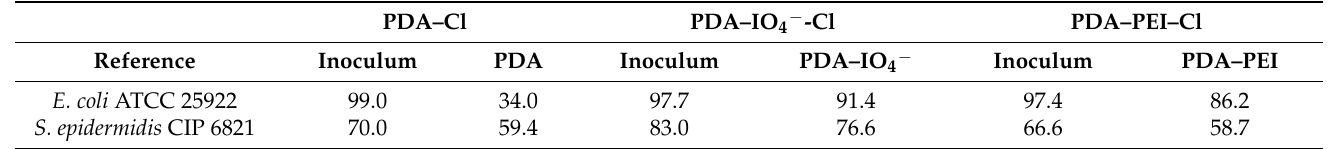
Table 4. Killing percentage (%killing) of chlorinated coating obtained from CFU numbering on agar plates referenced towards the bacterial inoculum and towards the non-chlorinated